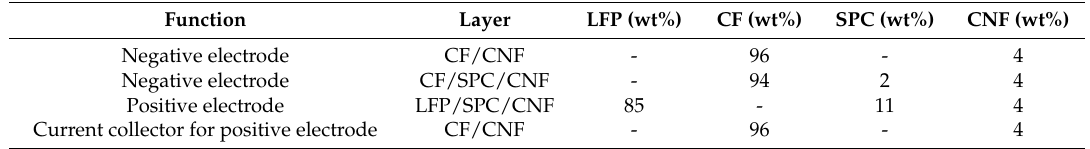
Table 3. Compositions of the